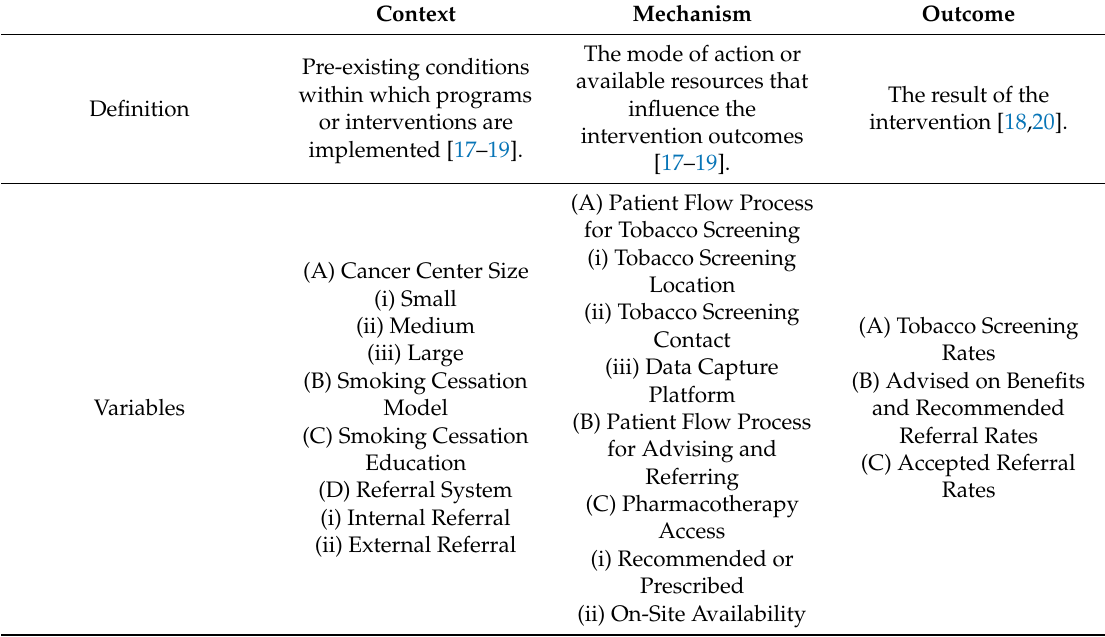
Table 1. Analytical Frame that anchored interpretation of context, mechanism and outcome variables of the smoking cessation intervention.